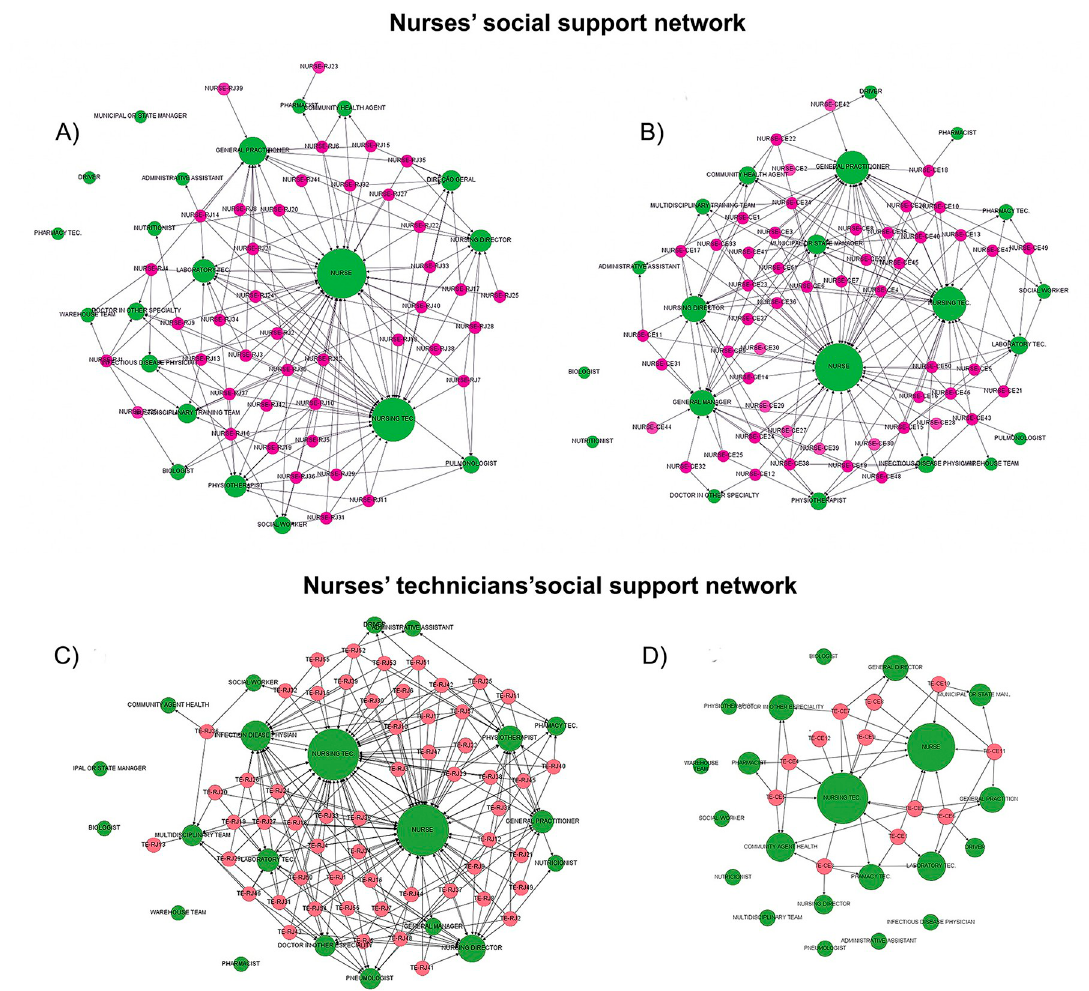
Fig 2. Nurses and nursing technicians’social support network sociograms–Rio de Janeiro and Ceara´. (A) Rio de Janeiro Nurse´s Sociogram. (B) CEara´ Nurse´s Sociogram. (C) Rio de Janeiro Nursing Technician´s Sociogram. (D) Ceara´ Nursing Technician´s